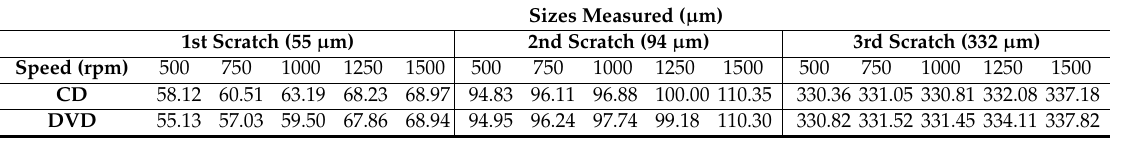
Table 4. Comparison of rotating speed and scratch sizes detected by CD and DVD pick-up heads.